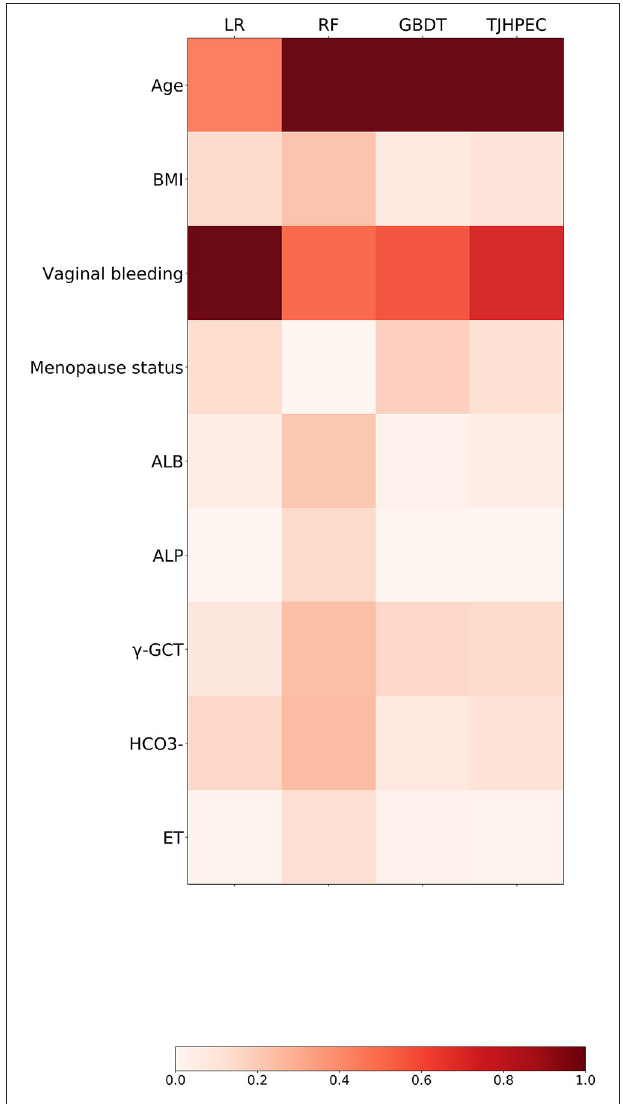
FIGURE 4 | Preponderance ranking of the top 20 features was performed using four models (LR, RF, GBDT, and TJHPEC) for the prediction of EC. The size of each circle represents its relative importance. The depth of the color indicates the importance of each feature in each